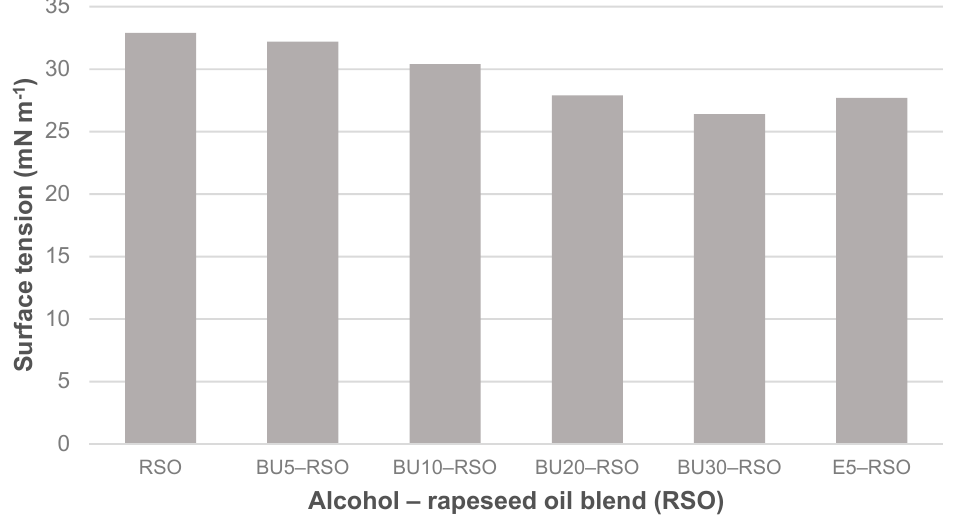
Figure 4. Surface tension measured for rapeseed oil, butanol-rapeseed oil and ethanol-rapeseed oil blends.